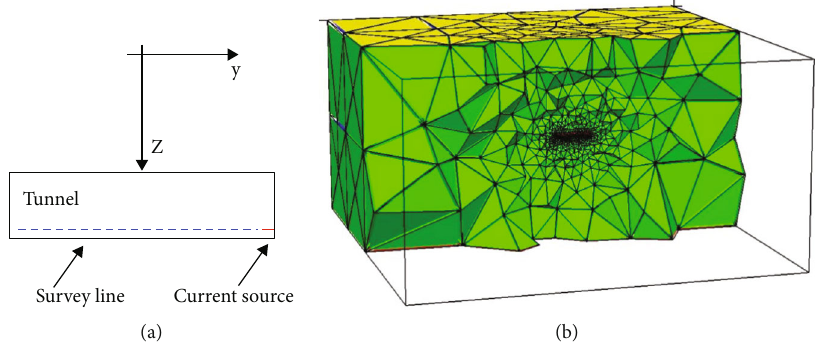
Figure 3: (a) Schematic illustration of a whole-space tunnel model. (b) Unstructured meshes of the